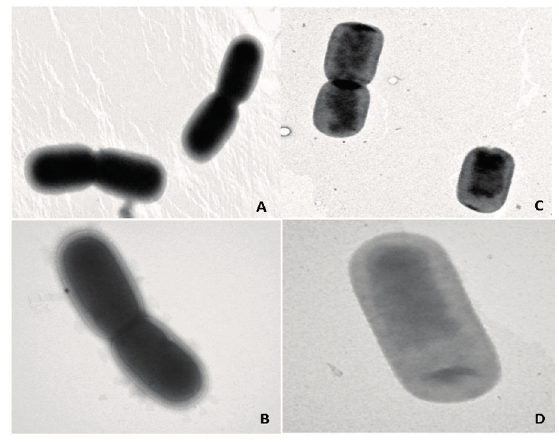
Figure 1. Structural features of the integral peptidoglycan isolated from L. paracasei subp. paracasei X12 (X12-PG) and the L. paracasei subp. paracasei X12 bacteria (X12) observed by transmission electron microscope (TEM). ( A , B ) The structure of X12 (×20,000, ×40,000); ( C , D ) The cylindrical structure of internal X12-PG (×20,000, ×40,000).